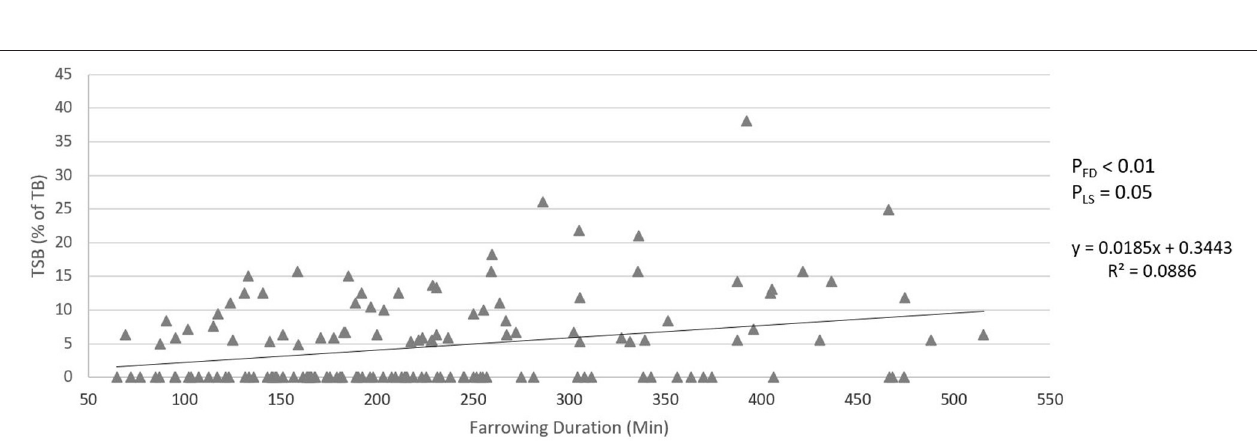
FIGURE 4 | Relationship between litter size and average piglet vitality score conducted within 30s after birth, using the scoring method as described by Baxter et al. (16) (LSmeans ± SEM). Analysis was performed on individual litters. p LS is the p -value for the fixed effect of litter size. p LSLin is the p -value for the linear effect of litter size.